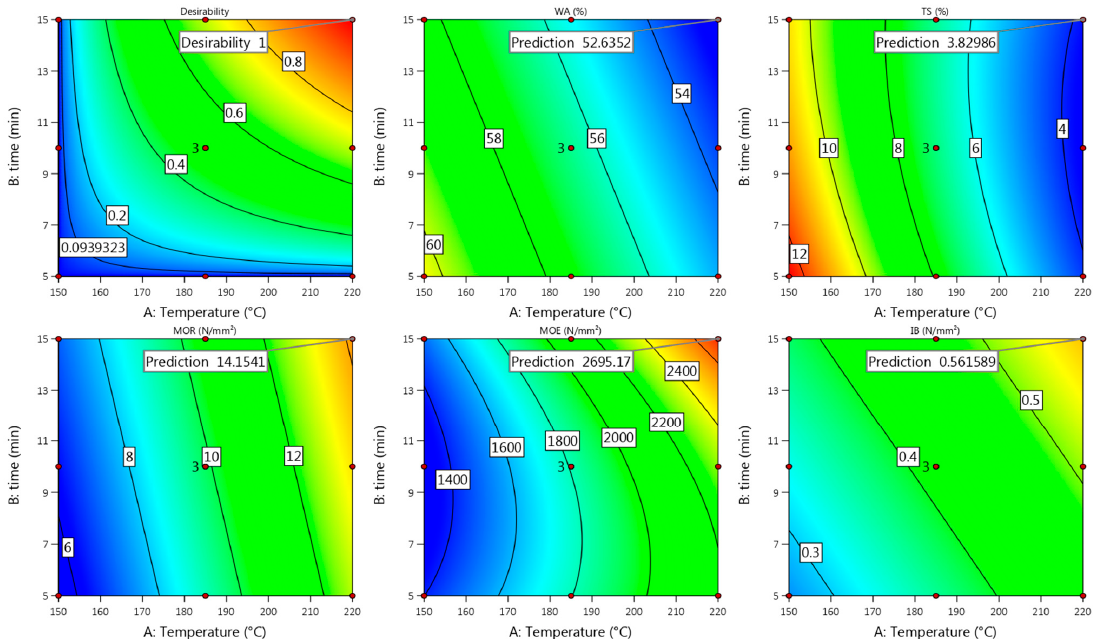
Figure 6. Contour plots with predicted values of the Wh-800 binder-less board properties at T = 220 °C and t = 15 min. T = 220 ◦ C and t = 15